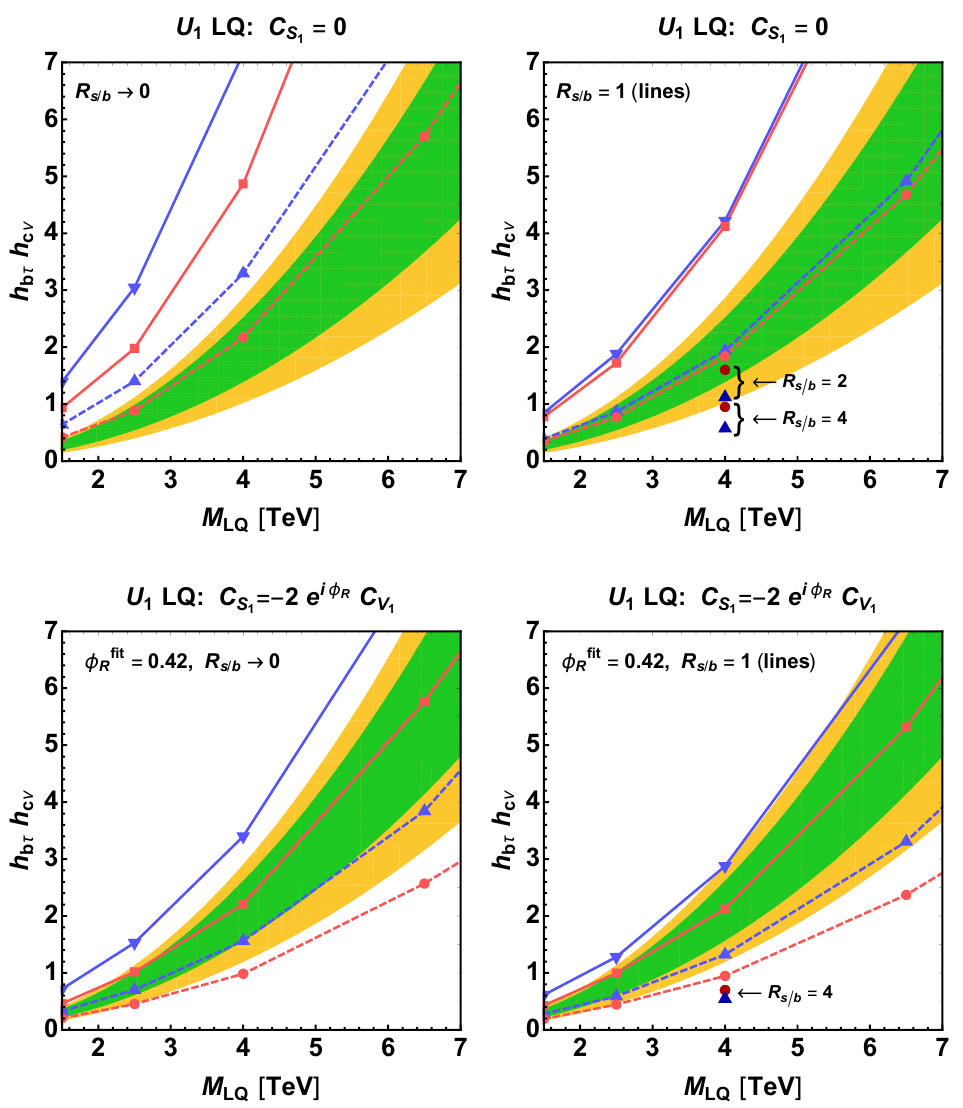
Figure 4 . Expected sensitivities to the U 1 LQ scenario. The vertical axis is a product of the h 23 ≡ h bτ h cν , and the horizontal one is the LQ mass, M LQ . Here, R U 1 couplings, h 33 L L and R s/b = 1 in the left and right panels, respectively. The R D ( ∗ ) anomaly is solved at the 1 σ (green) and 2 σ (yellow) levels. See figure 1 for the conventions of the plot markers and colors. The sensitivities for R s/b = 2 , 4 and 4 are also shown in the single-U 1 and U(2) -U 1 scenarios, respectively, at M LQ = 4 TeV